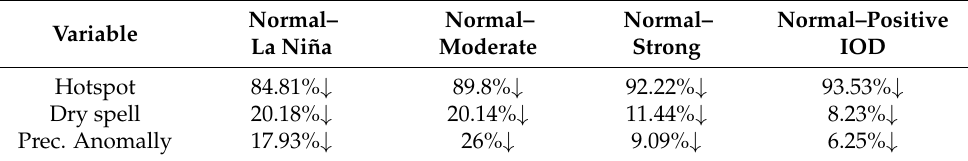
Table 4. Early year dry season—difference value of the PDF from years categories. Variable